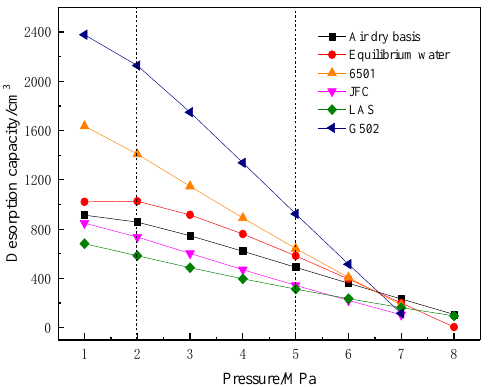
Figure 15. Variation in desorption capacity of samples with different surfactants. (2)